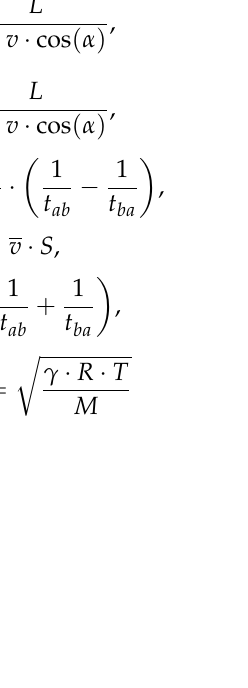
Figure 1. Measurement principle.